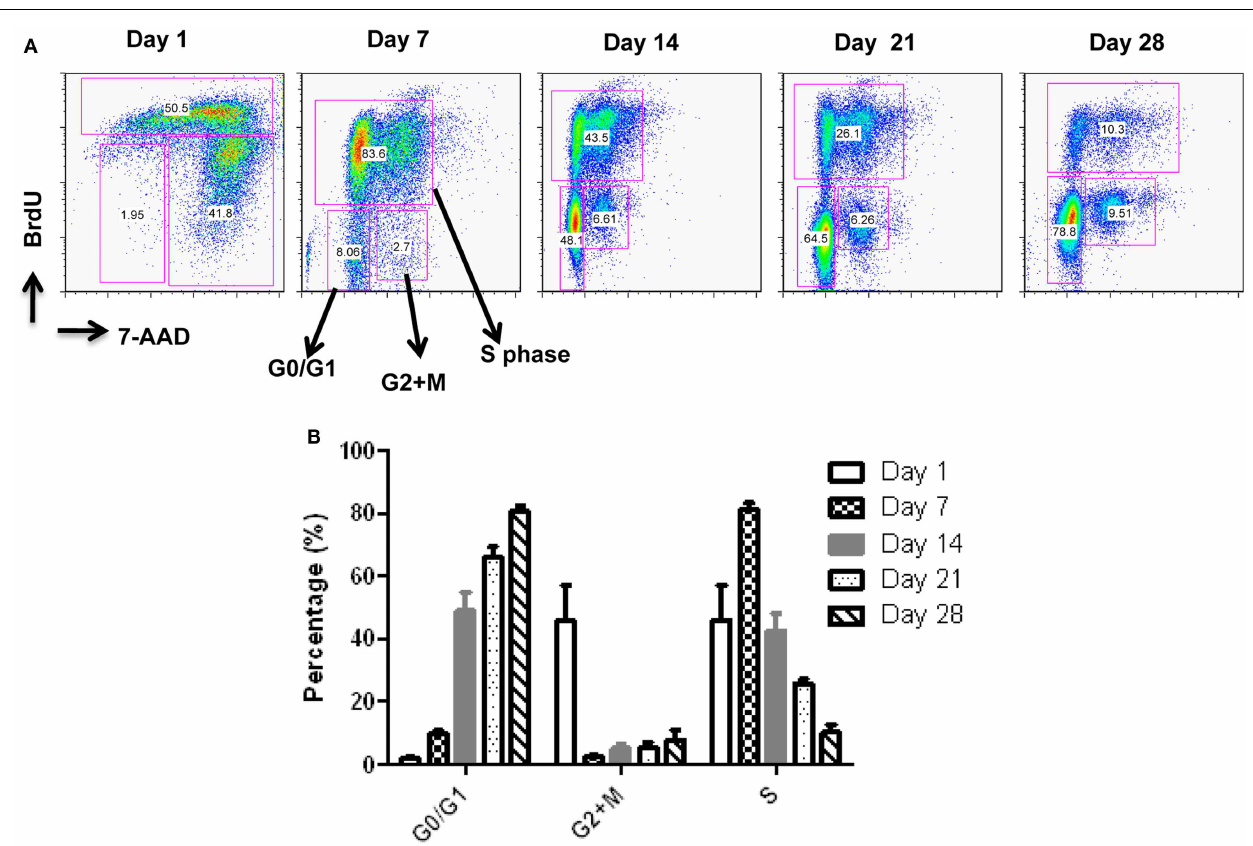
FIGURE 3 | Cell cycle analysis of expanded pNK cells . (A) Representative APC-BrdU/7-AAD cell cycle analysis of ex vivo -expanded pNK at different time points as indicated. (B) Cell cycle analysis at different phases from ex vivo -expanded pNK at different time points as indicated ( n = 5).